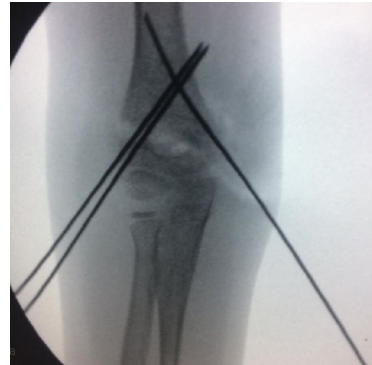
Figure 1. Detailed analysis chart of patients included and excluded from the study.